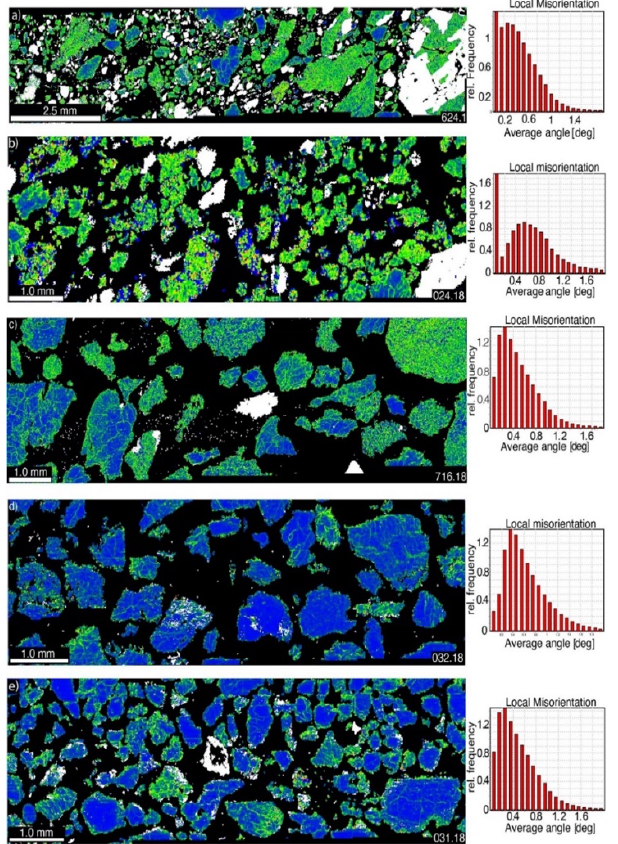
Figure 4. Local misorientation map (Kernel average misorientation, KAM) of quartz grains, based on local distortion of crystal lattice caused by geometrically necessary dislocations (GND) and the local misorientation histograms of each sand sample. Note: grains colored in blue have low dislocation densities contrasting with those in green, yellow, orange, and red, which have an increasing density of dislocations. Areas in white correspond to grains other than